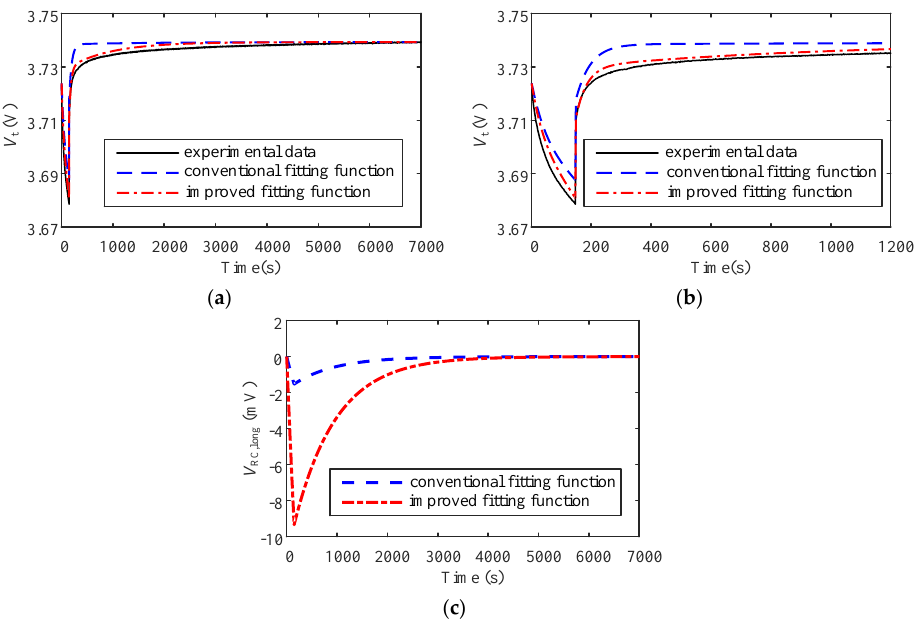
Figure 12. Voltage curves of one cycle of the discharging pulse-rest test (62%–60%): ( a ) the overview; ( b ) a close look; ( c ) the voltage across the long-term RC network. Table 3. Comparison of RMSE at different SoC .